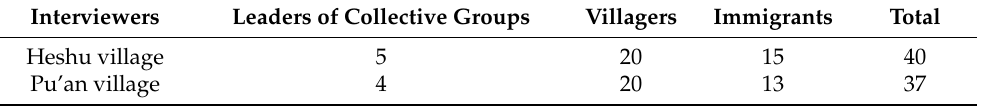
Table 2. The structure of interviews in Heshu village and Pu’an village.